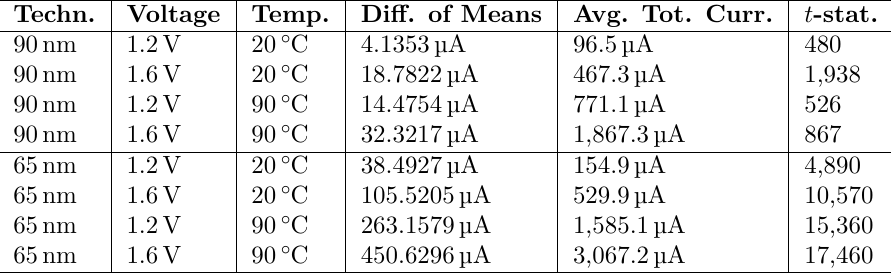
Table 1: Comparison of high-fanout register leakage in 65 nm vs. 90 nm technology for different operating conditions.